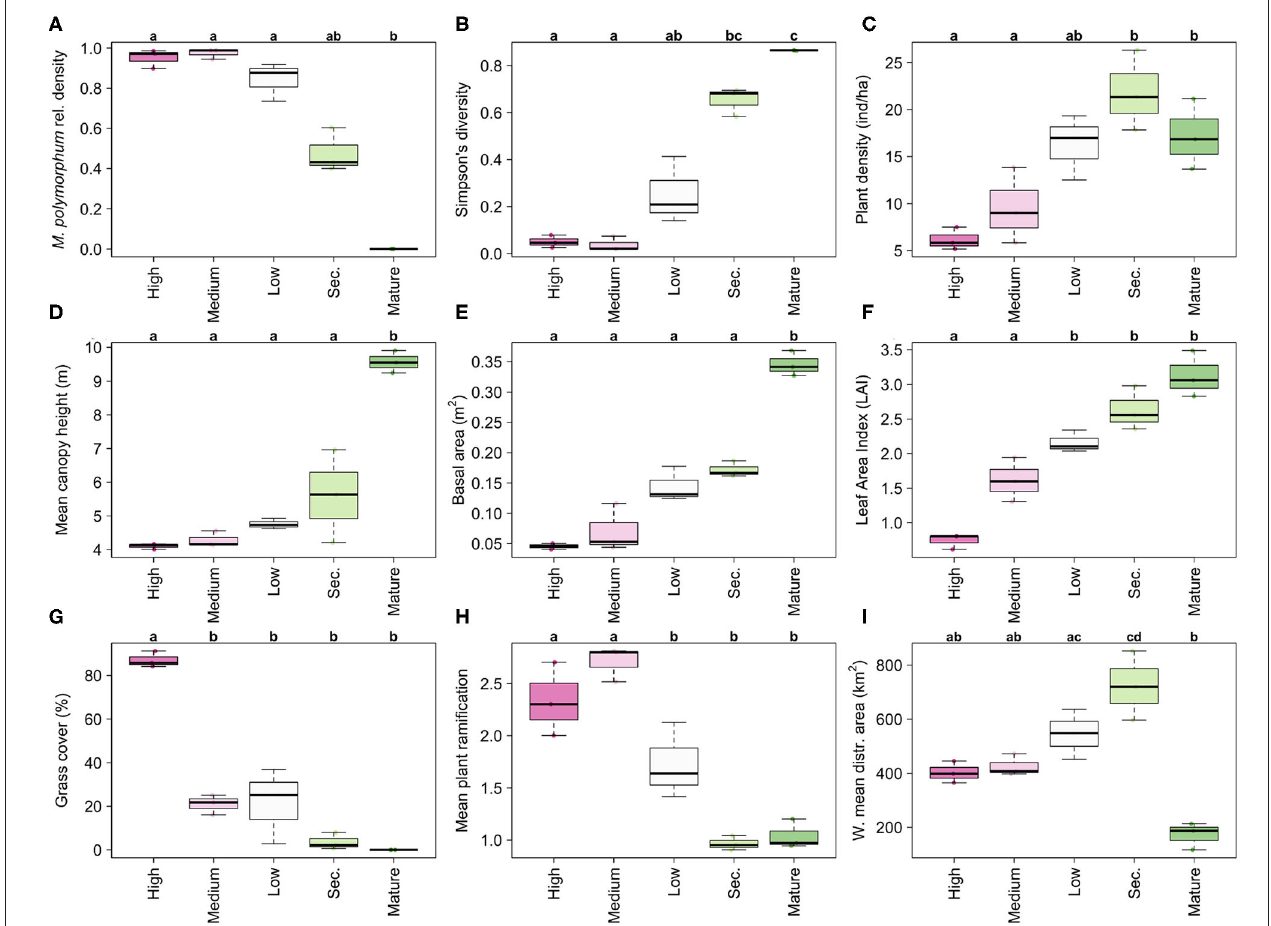
FIGURE 2 | Diversity and structure of secondary vegetation along a fire gradient that combines an increasing number of fire events and less time for recovery. High disturbance: four fire events and 0.5 years post-fire. Medium disturbance: three fire events and 8 years post-fire. Low disturbance: one fire event and 20 years post-fire. Secondary forests: no fire events and at least 36 years of regeneration. Old-growth forests, no fire events and they were confirmed forests since 1956 (at least 54 years of regeneration but possibly more). (A) Relative dominance of Moquiniastrum polymorphum , (B) Simpson’s diversity, (C) plant density, (D) mean canopy height, (E) total basal area, (F) Leaf Area Index (LAI), (G) percent grass cover and (H) mean plant ramification increased with lower disturbance intensity, indicating the structural recovery of secondary vegetation. (I) The mean area of distribution of the species increased from harsher to milder fire regimes and peaked in secondary forests, but the reference mature forests had the lowest values. Letters indicate significance groups ( α = 0.05) following a permutation-based ANOVA with a post-hoc pairwise comparison (Basso et al., 2009). The statistics for these comparisons are in Supplementary Material